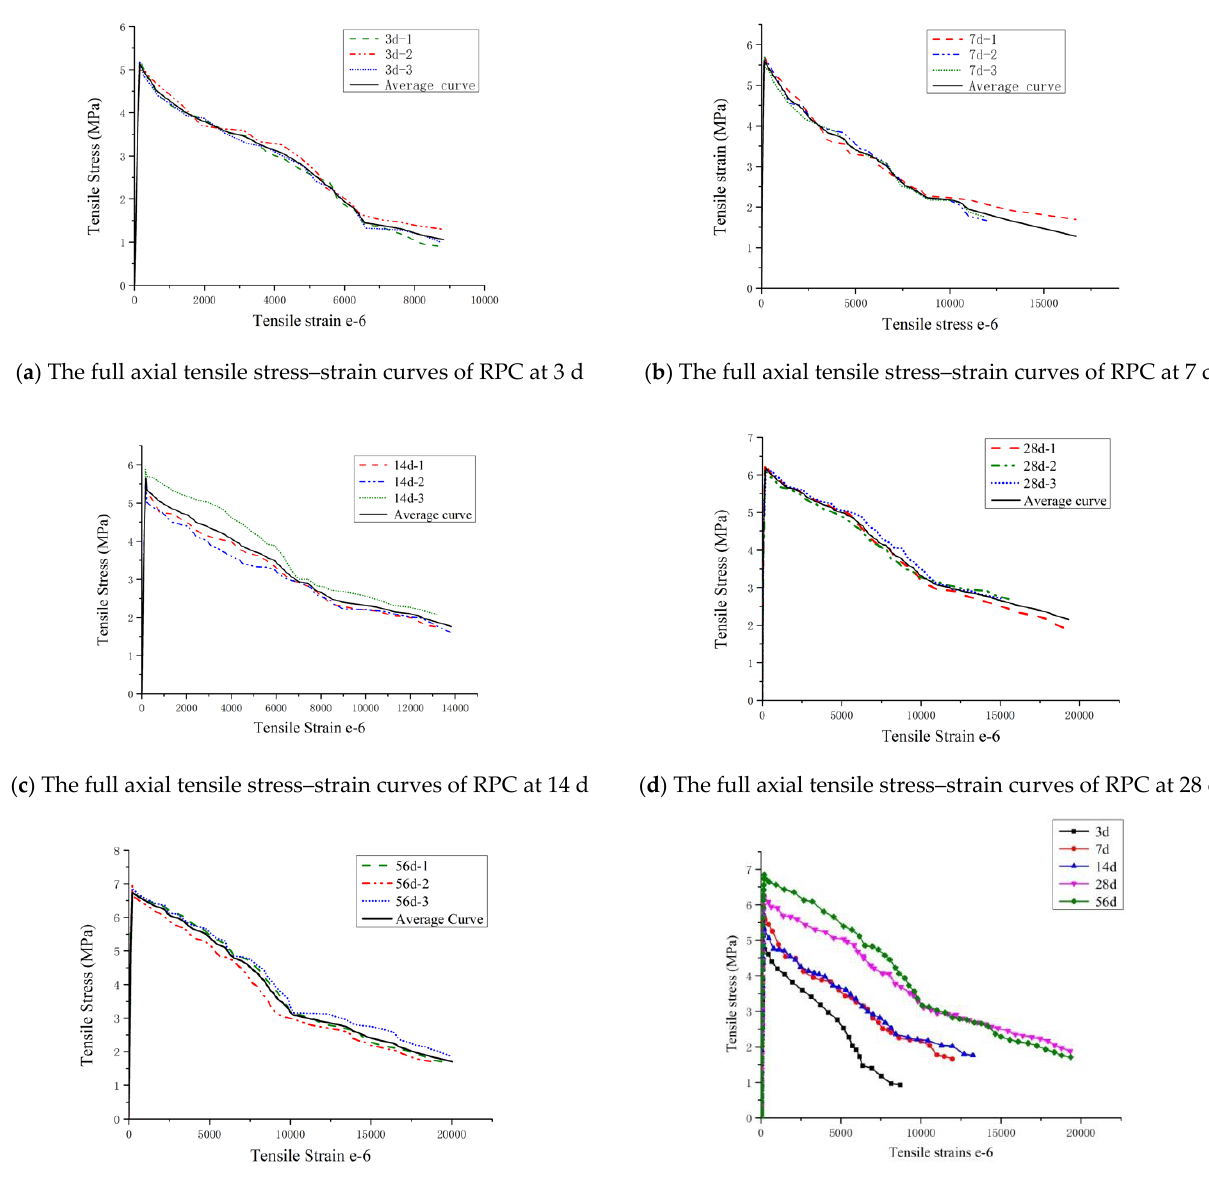
Figure 5. The full axial tensile stress–strain curves of the RPC at various curing ages.